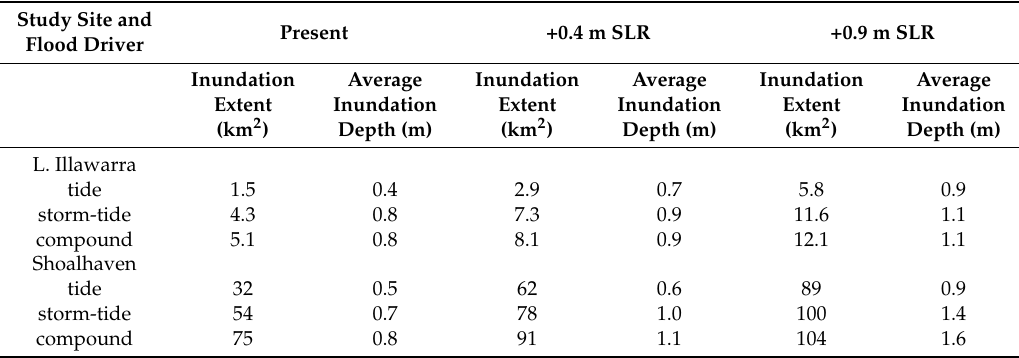
Table 2. Modelled inundation extents and rounded average inundation depths at Lake Illawarra and Shoalhaven Estuary for flood driver and scenario combinations. SLR: Sea-level